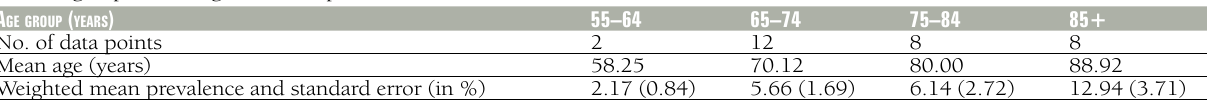
Table 4 Age–specific weighted mean prevalence (%) of dementia in Africa